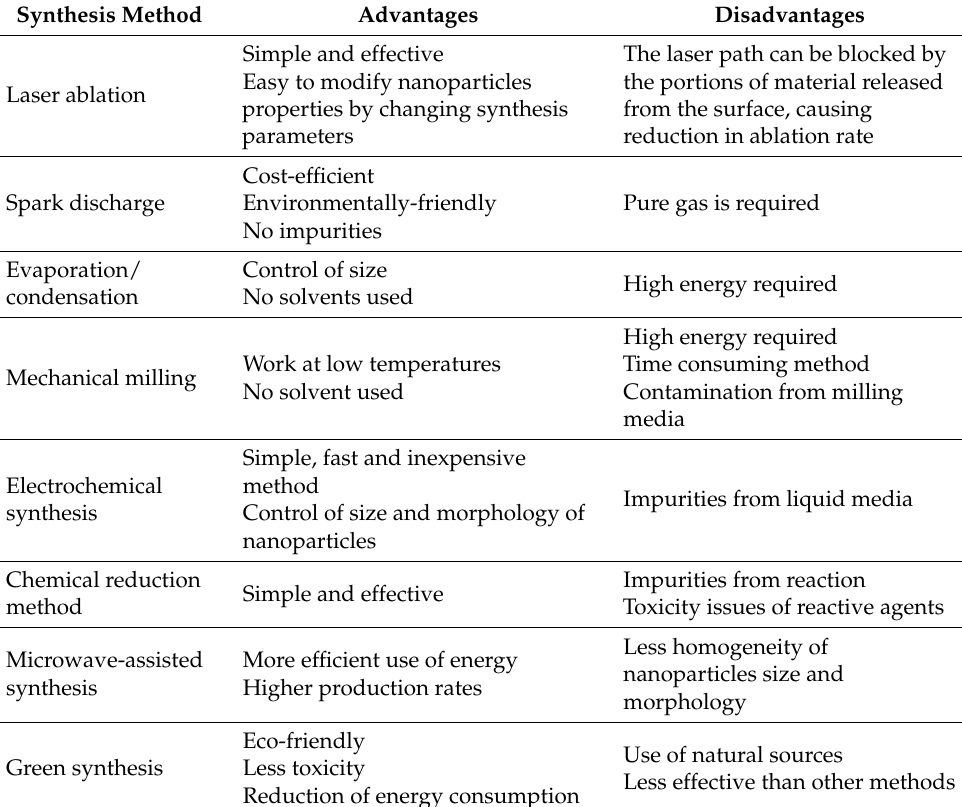
Table 1. Production methods of metal nanoparticles